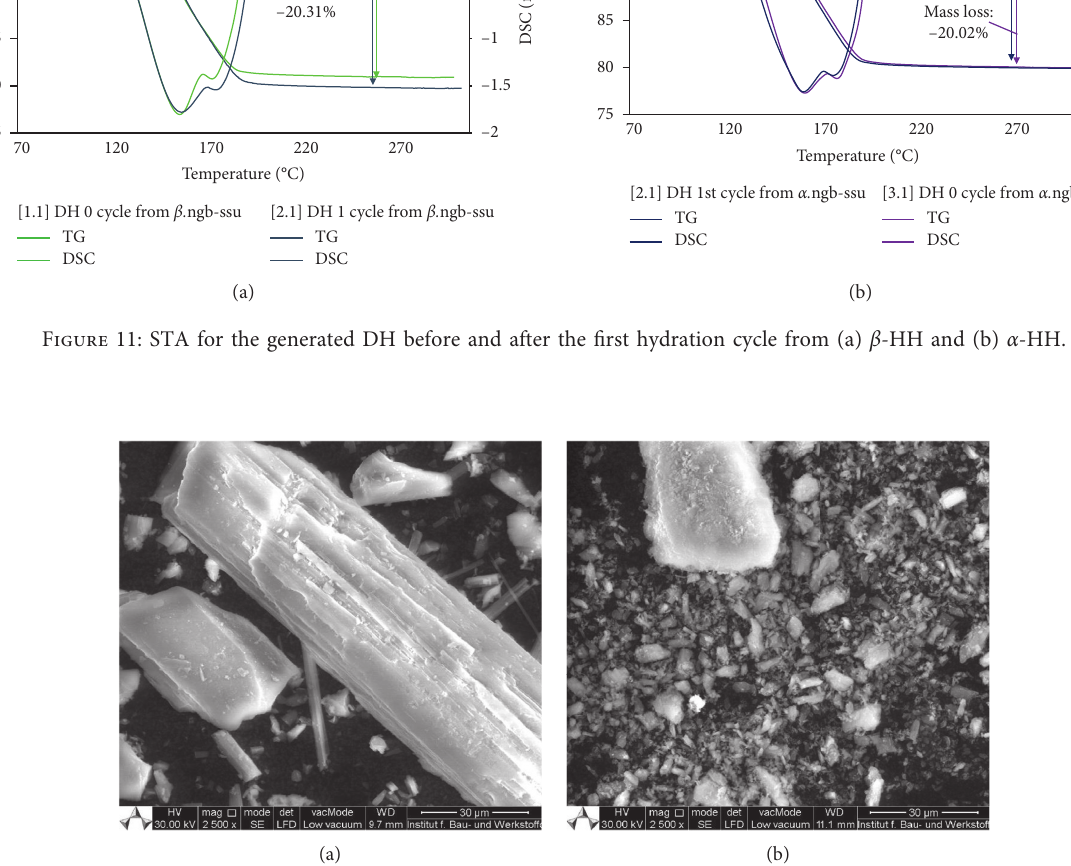
Figure 12: SEM images pure: (a) SA α -HH and (b) SA α -HH after the first